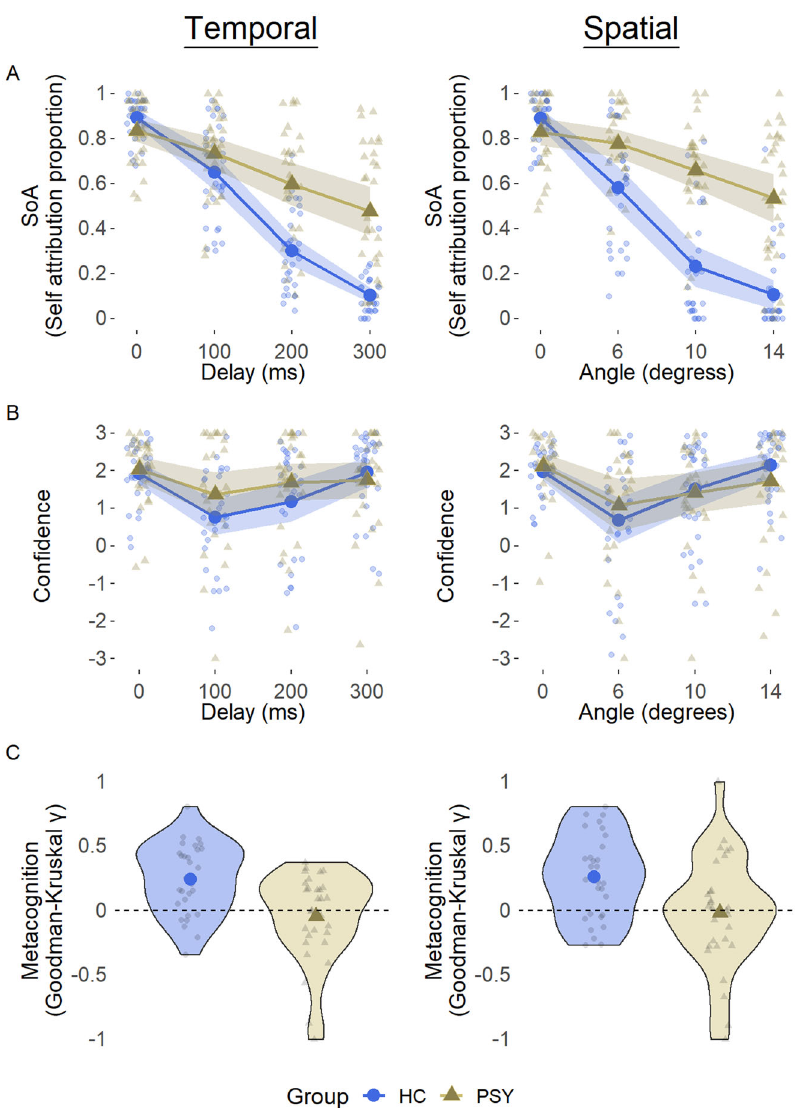
Fig. 1 Group mean and individual ratings of SoA, con fi dence and metacognitive performance. A Self attribution in the temporal aspect (left) and in the spatial aspect (right). Shaded area represents 95% CI, large shapes represent group means. B Con fi dence in the temporal (left) and spatial (right) aspects following correct answers to the SoA question. C Distribution of metacognitive performance in the temporal (left) and spatial (right) aspects.